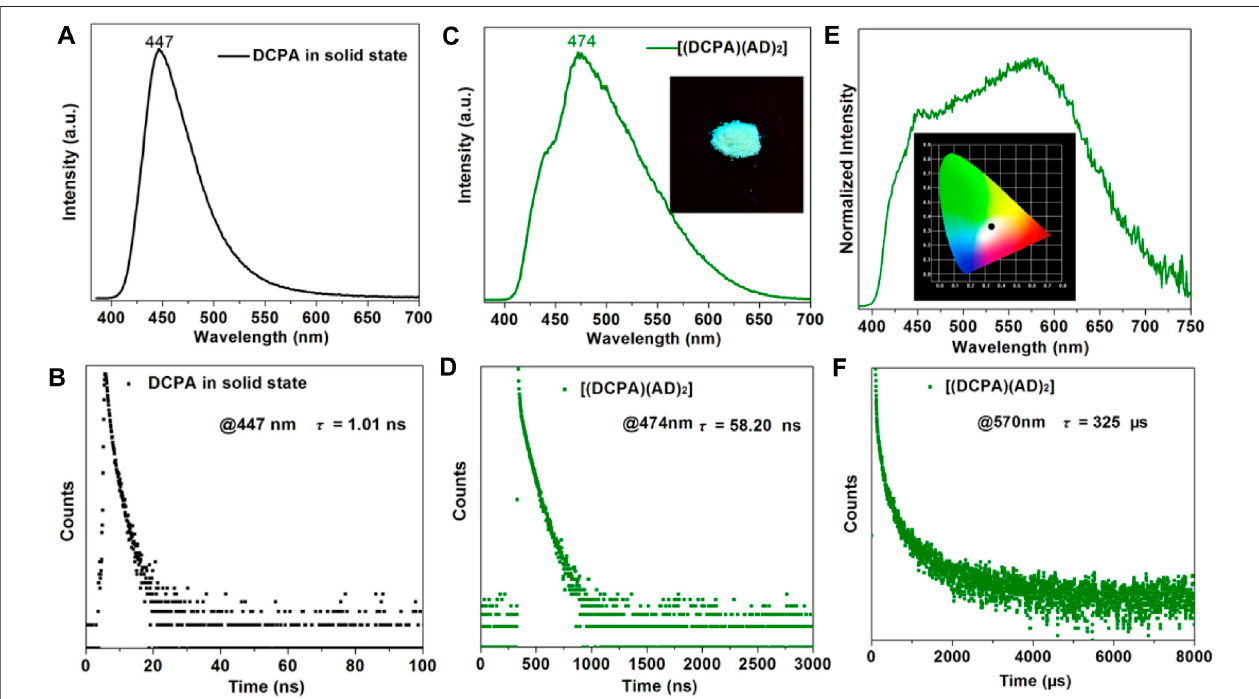
FIGURE3| Fluorescencespectra (A) decaycurve (B) ofDCPA insolidstate( λ ex (cid:1) 329 nm).Fluorescencespectra (C) decaycurve (D) of[(DCPA)(AD) 2 ] co-crystal in solid state ( λ ex (cid:1) 365 nm). Insert shows solid state samples under UV (365 nm) light radiation. Phosphorescence spectra (E) decay curve (F) of [(DCPA) (AD) 2 ] co- crystal in solid state ( λ ex (cid:1) 365 nm). Insert shows CIE-1931 chromaticity diagram (0.33,0.34) of [(DCPA) (AD) 2 ] co-crystal with white phosphorescence emission. All of these measurements were recorded under ambient